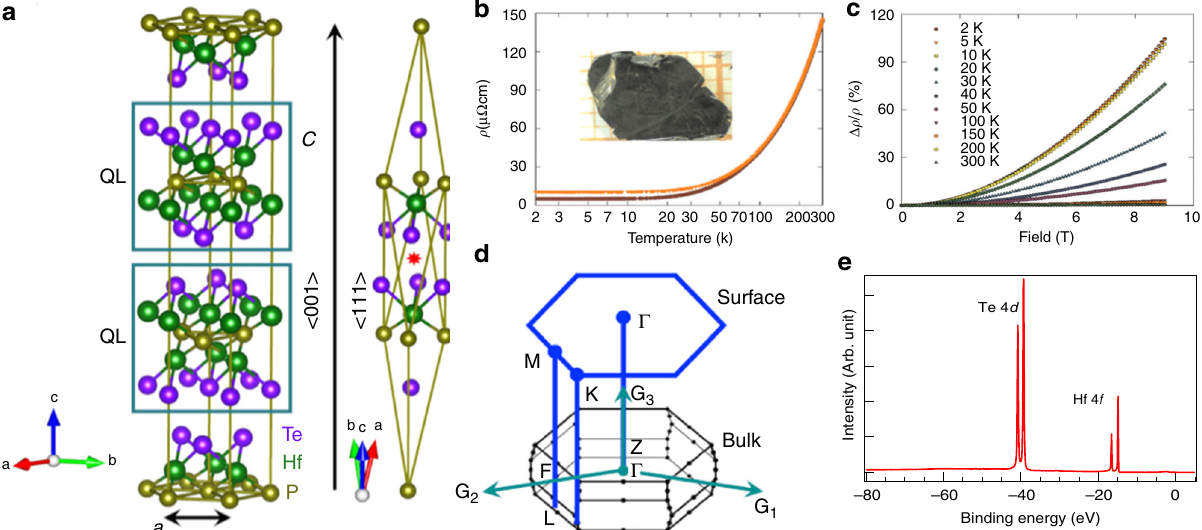
Fig. 1 Crystal structure and sample characterization of Hf 2 Te 2 P. a The rhombohedral tetradymite crystal structure of Hf 2 Te 2 P, depicted in the conventional (hexagonal) and primitive (rhombohedral) unit cells. The stacking of quintuple layers (QL) is depicted by the blue square. The inversion center is indicated with the red star. b Temperature dependence of the electrical resistivity measured on a single crystal of Hf 2 Te 2 P in a zero (brown circles) and 9 T (orange triangles) magnetic fi eld applied perpendicular to the current fl owing within the basal plane of the crystallographic unit cell. The inset shows a picture of one of the single crystal grown for the present research. c Magnetic fi eld dependencies of the transverse magnetoresistance measured for a range of different temperatures on a single crystal of Hf 2 Te 2 P with current fl owing within the basal plane of the crystallographic unit cell. d 3D bulk Brillouin zone and its projection on the hexagonal surface Brillouin zone of the Hf 2 Te 2 P-crystal. High symmetry points are marked in the plot. e Core level spectroscopic measurement of Hf 2 Te 2 P. Sharp peaks of Te 4 d and Hf 4 f are observed which indicate good sample